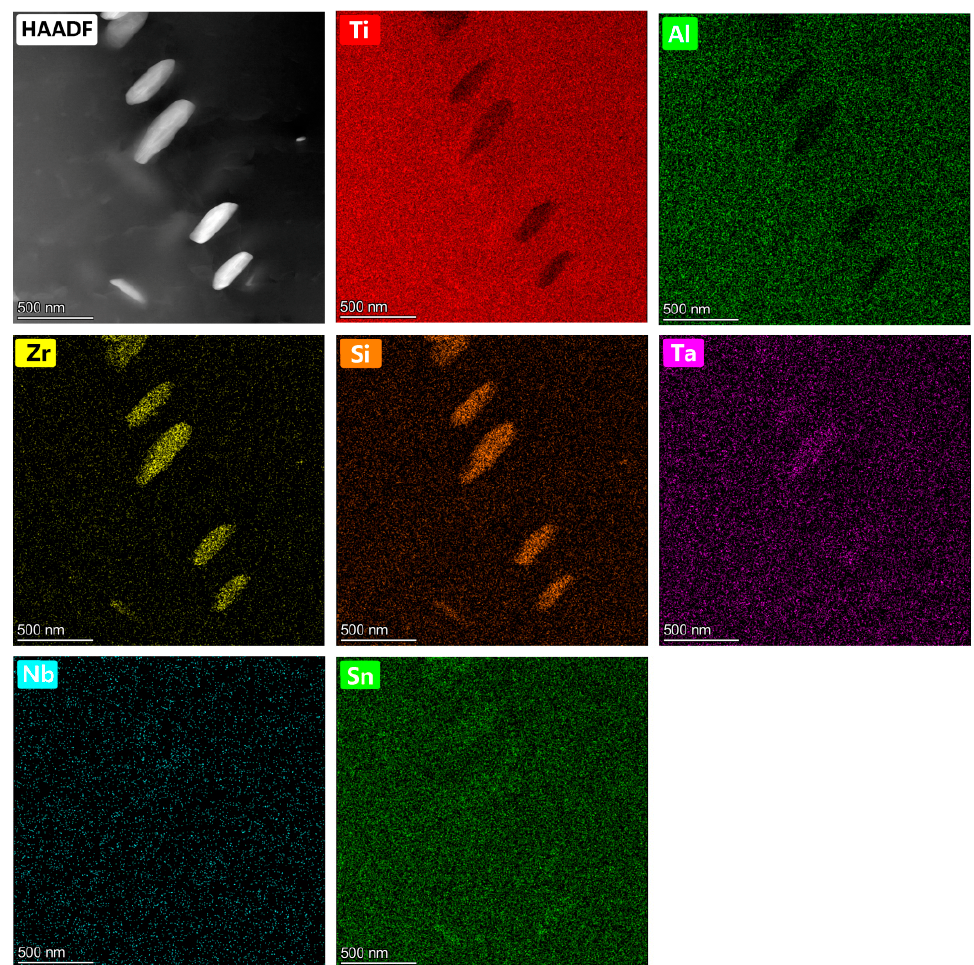
Figure 7. HAADF-STEM image and EDS maps of a typical silicide precipitates region.